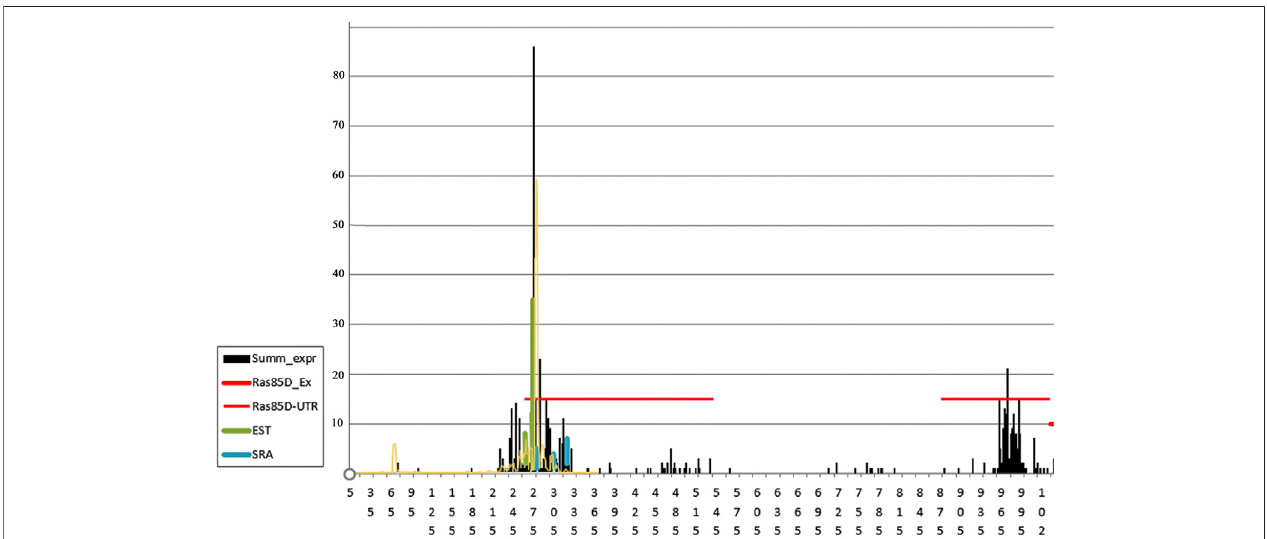
FIGURE6| FrequenciesofreadsaroundTSSintheintergenicregionand5 ′ UTRofthe ras85D genein D.melanogaster. Horizontalredlinesmarktheboundariesof the 5 ′ UTR fragments broken by intron 1. The number of reads is indicated on the Y-axis. The total data on the TSS read frequencies, obtained by the 5 ′ -SAGE method from samples of embryos, larvae, young females, young males, old females, and old males (MachiBase), are highlighted in black; the data obtained from a sample of embryosusingtheCAGEmethodaremarkedinyellow(Hoskinsetal.,2011),thereadsoftheESTandSRAlibrariesareshowningreenandblue (Supplementary Table S5)